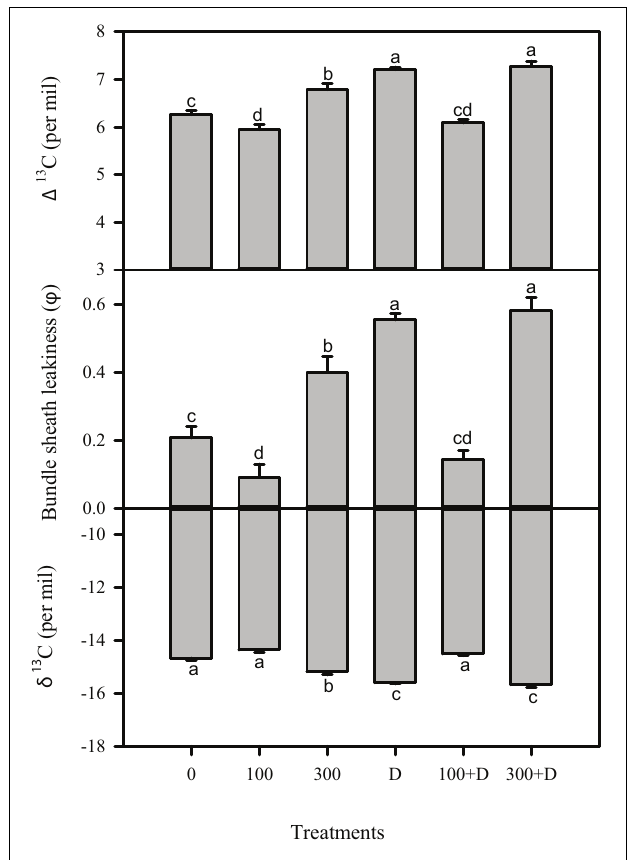
FIGURE 4 | Measurement of carbon isotope in the leaf of Panicum antidotale under salinity, drought, and a combination of both treatments. Carbon isotope discrimination in the leaf ( (cid:49) 13 C), bundle sheath leakiness ( ϕ ), and carbon isotope in leaf ( δ 13 C) showed variations under treatments of 0, 100, and 300 mM NaCl, drought (D), and a combination of salinity with drought [100 and 300 mM NaCl + drought (100 + D and 300 + D, respectively)]. Different letters denote, after Bonferroni post hoc test, significant difference ( P < 0.05).